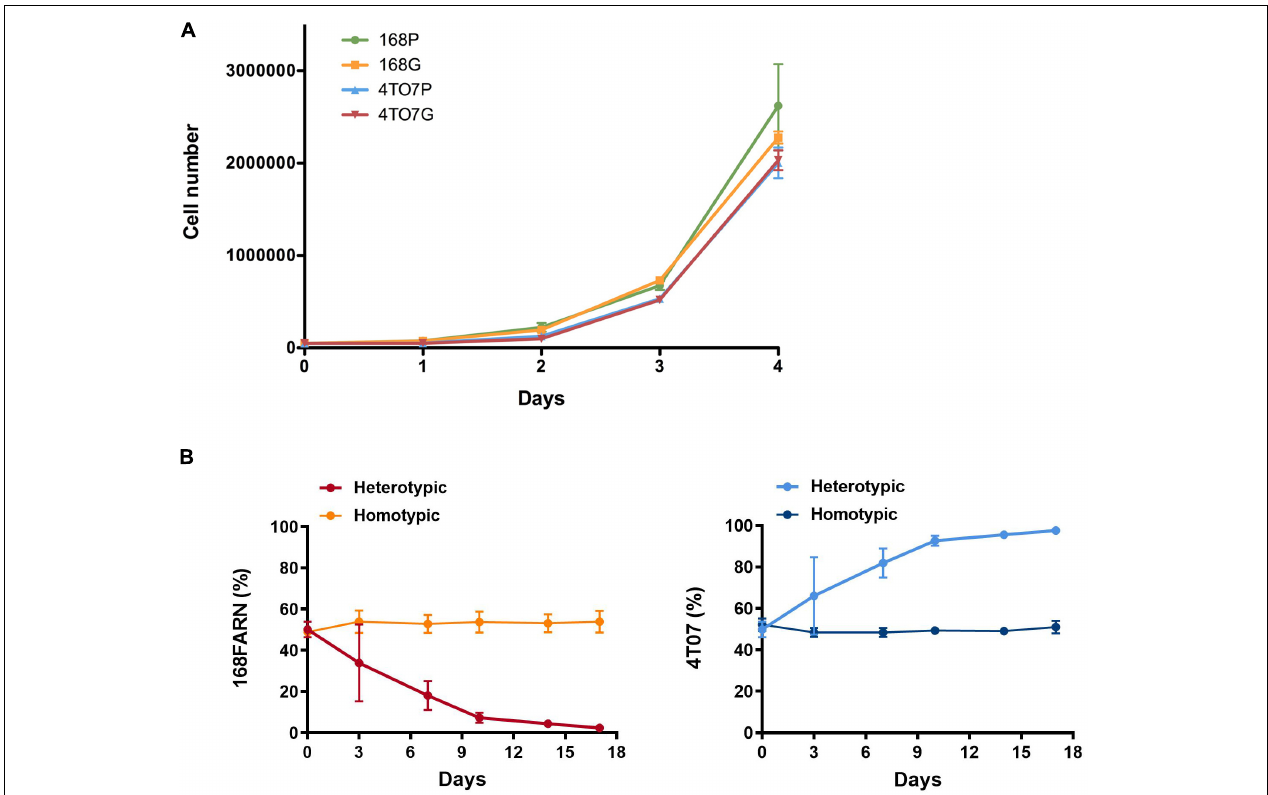
FIGURE 1 | Mutual impacts on subclonal growth. (A) 168FARN and 4T07 parental cells were transduced either with an empty retroviral vector (168P and 4T07P) or with labeled with a GFP-encoding retrovirus (168G and 4T07G). Cells were seeded in triplicate in six-well plates at a density of 50,000 cells/well and cultured for the indicated times before harvesting and counting. (B) 10 5 Cells were seeded at a 1:1 ratio in homotypic (parental and GFP expressing derivative of the same cell line) or heterotypic (different cell lines, one expressing GFP) co-cultures and harvested and replated at the initial densities (10 5 cells/plate) at indicated times. The ratios of GFP-labeled to unlabeled cells were estimated by flow cytometry. The results represent data from three independent experiments and are shown as mean ±